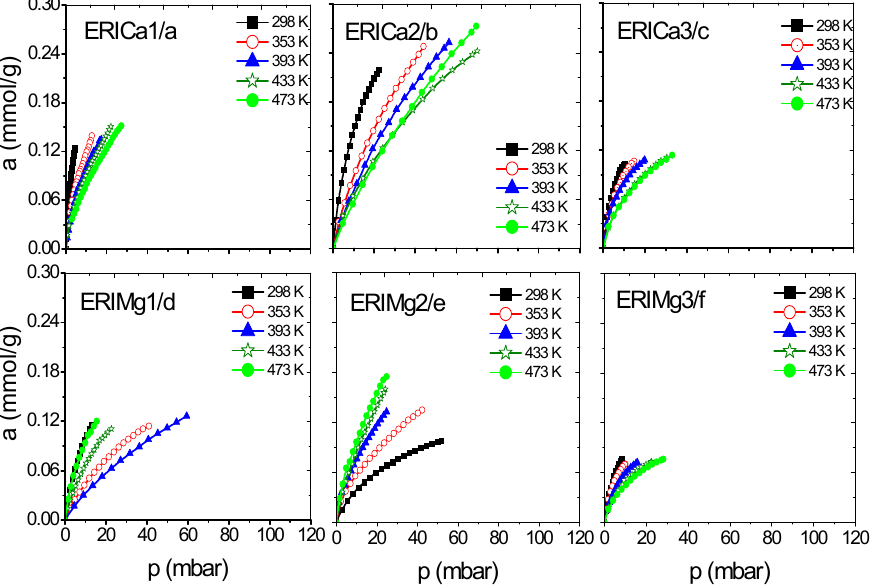
Figure 7. CH 4 adsorption isotherms at different temperatures on: ( a – c ) ERICa and ( d – f ) ERIMg exchanged zeolites.